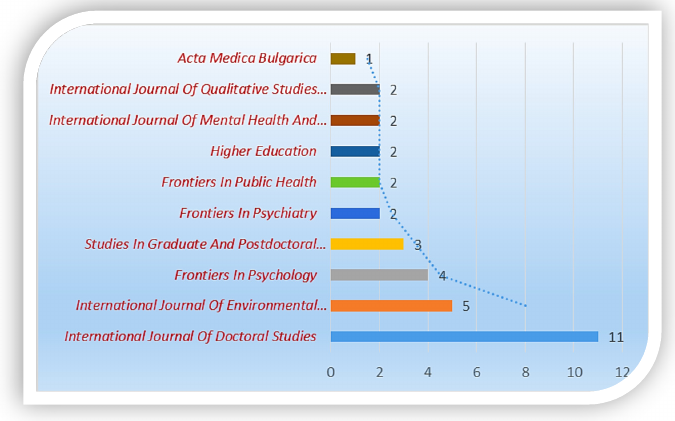
Figure 10. The top 10 journals with the highest number of publications (retrieved).